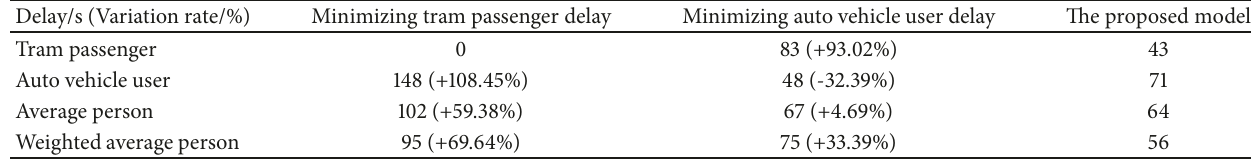
Table 9: Performance comparison by different